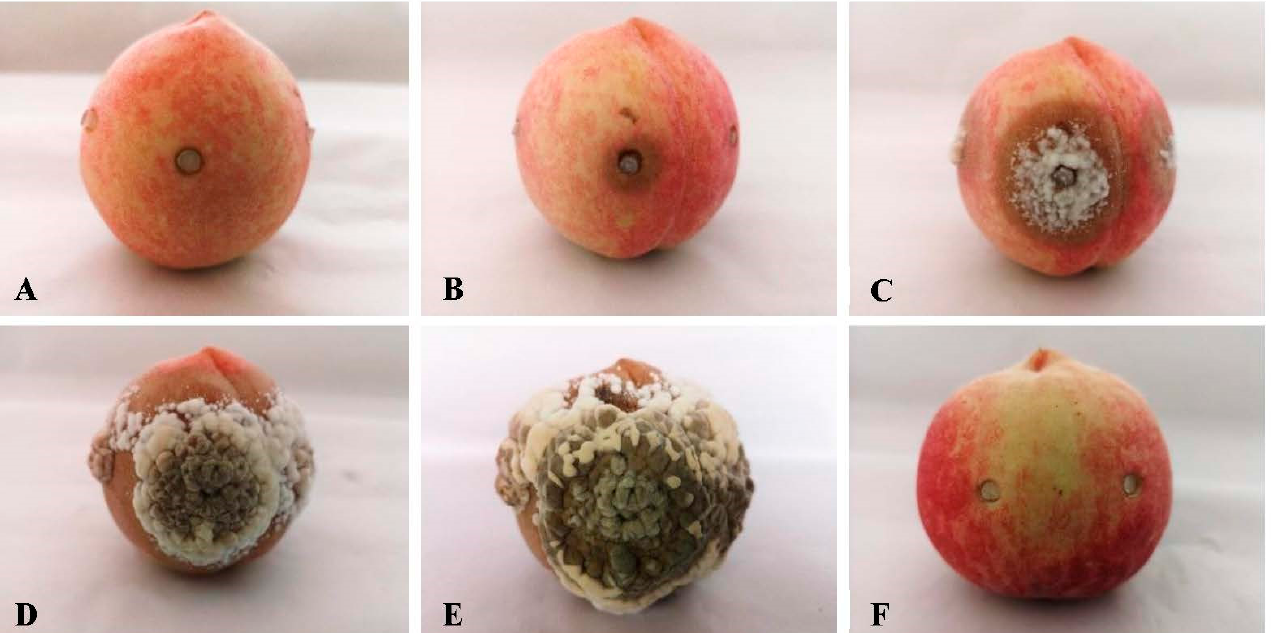
Figure 3. Symptoms from the pathogenicity tests on peach fruit samples at different days after inoculation with the isolate T8-1: ( A – E ) the symptoms at 2, 3, 4, 5, and 6 days after inoculation with the T8-1 isolate; ( F ) the control peach at 6 days after inoculation with sterile PDA plugs without the T8-1 isolate (control).